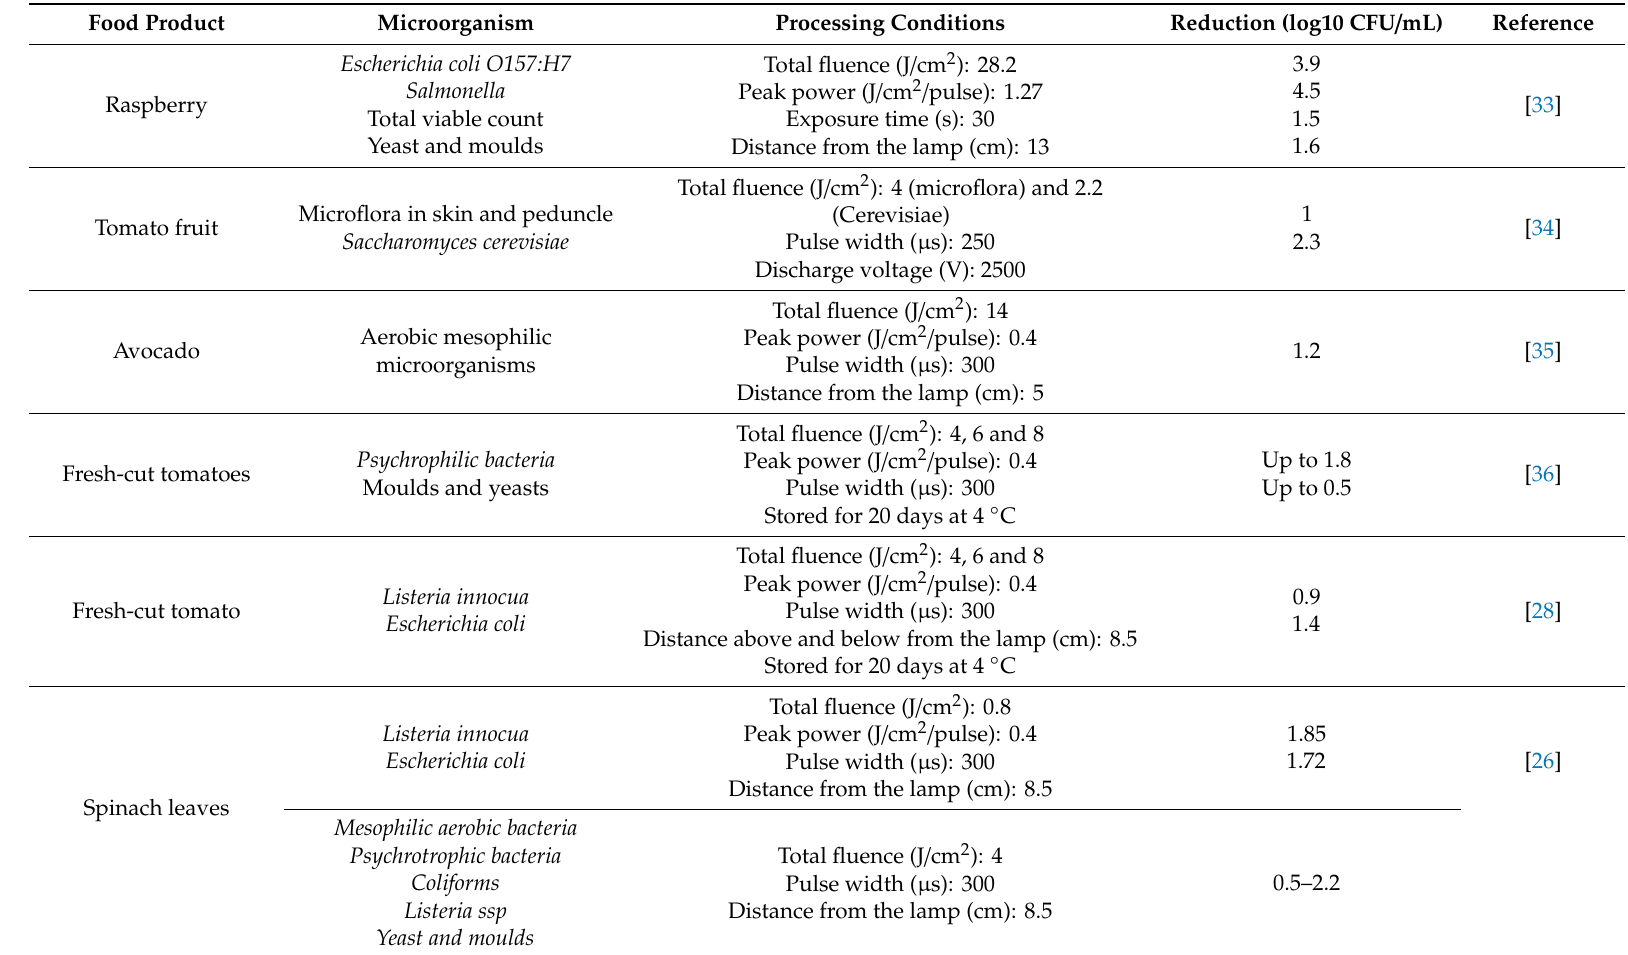
Table 1. Microbial reduction levels for fruits and vegetables after pulsed light